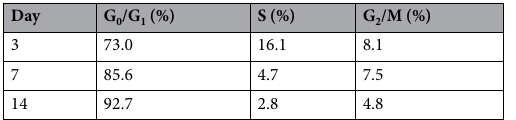
Table 1. Cell cycle analysis of primary RPE